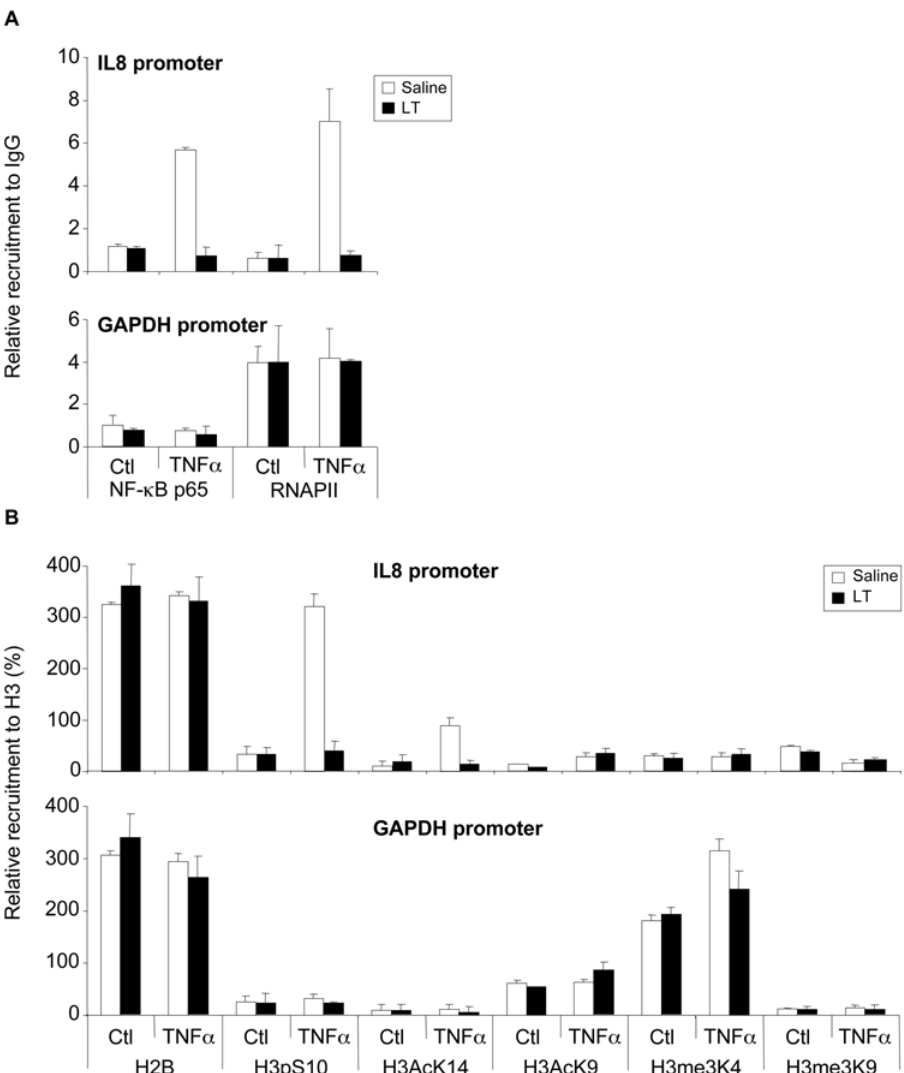
Figure 6. LT impairs IL-8 promoter accessibility. Beas-2B cells were incubated for 1 h with LT (1 m g/ml) and stimulated with TNF a (10 ng/ml) for additional 45 min. Cells were fixed with formaldehyde and then chromatin sonicated. The relative recruitment of NF- k B-p65 (p65) and the RNAPII (RNA Polymerase II) ChIP were expressed relative to the non-immun IgG rabbit used as a negative control (A). The H2B and the H3 histone tail modifications ChIP were reported to the H3 ChIP and expressed in percentages (B). Each value was corrected for the recruitment of each antibody on the CD44 exon 2 region used as an unregulated control gene by the TNF a and the LT. Note that the H2B signal relative to H3 is constant upon treatment and the promoters. It was three times more important than H3, probably because of the relative efficiency of